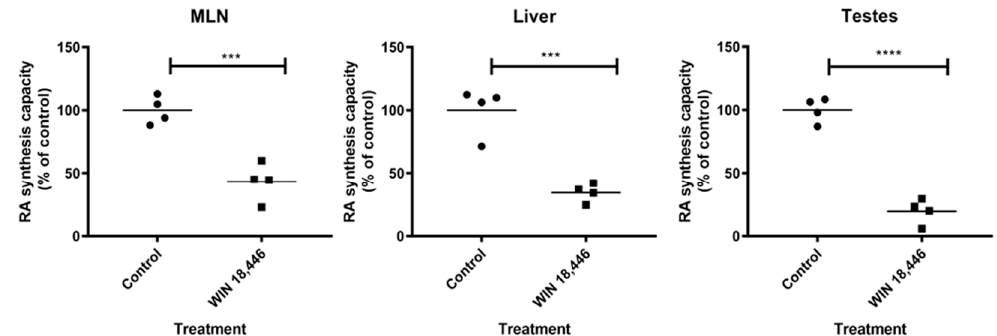
Figure 4. WIN 18,446 significantly suppresses RA synthesis capacity in tissues. S10 fractions containing ALDH1A enzymes were prepared from various tissues collected from mice 24 h following treatment with WIN 18,446 or vehicle alone (Control). RA synthesis capacities of the tissue S10 fractions were determined by measuring their RA production after incubation with substrate, retinal, by LC-MS and expressed as percent of control. Mean is shown (horizontal line). *** p < 0.001, **** p < 0.0001, Student’s t test.